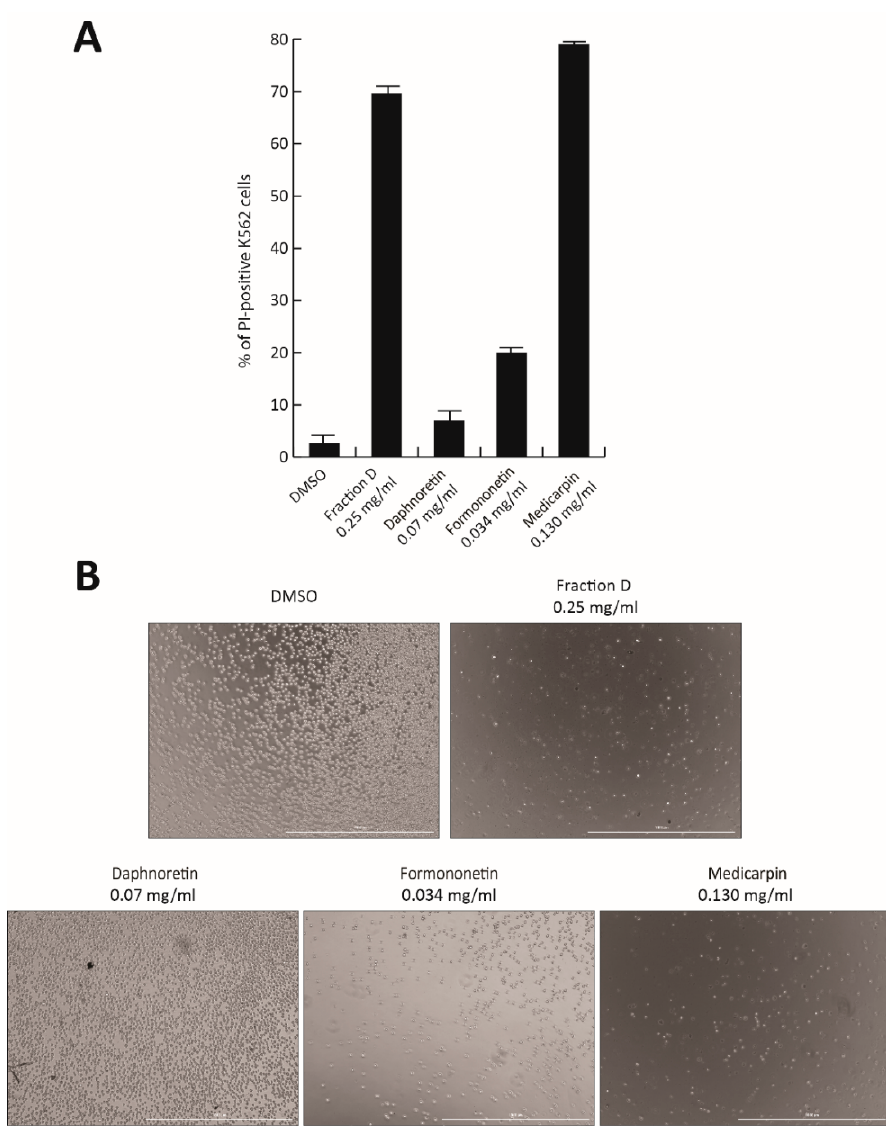
Figure 7. Antiproliferative effect of separate components of Fraction D. ( A ) K562 cell death analysis by propidium iodide (PI) after treatment with Fraction D, Daphnoretin, Formononetin, and Medicarpin for 48 h, at the indicated concentrations. ( B ) Images of K562 cells after treatment with Fraction D, Daphnoretin, Formononetin, and Medicarpin for 48 h, at the indicated concentrations.